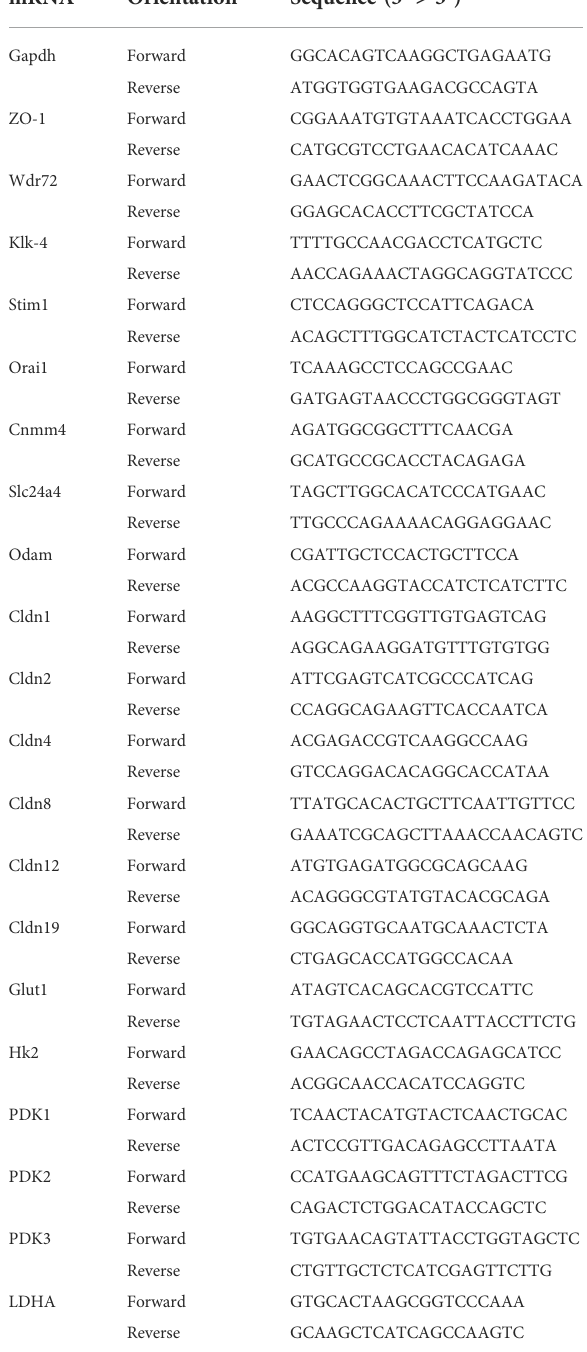
TABLE 1 List of PCR primer used in this